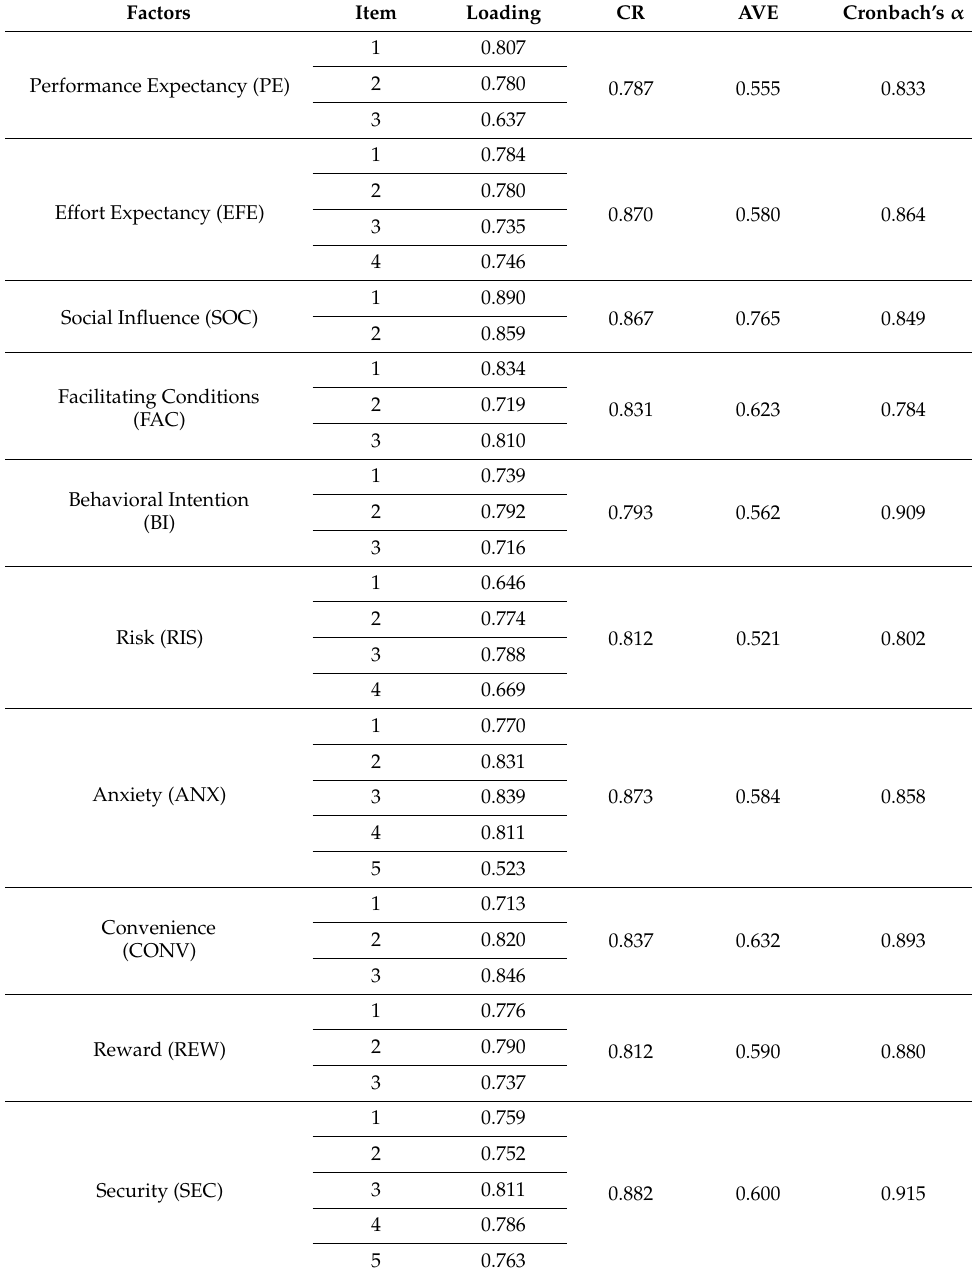
Table 1. Reliability and convergent